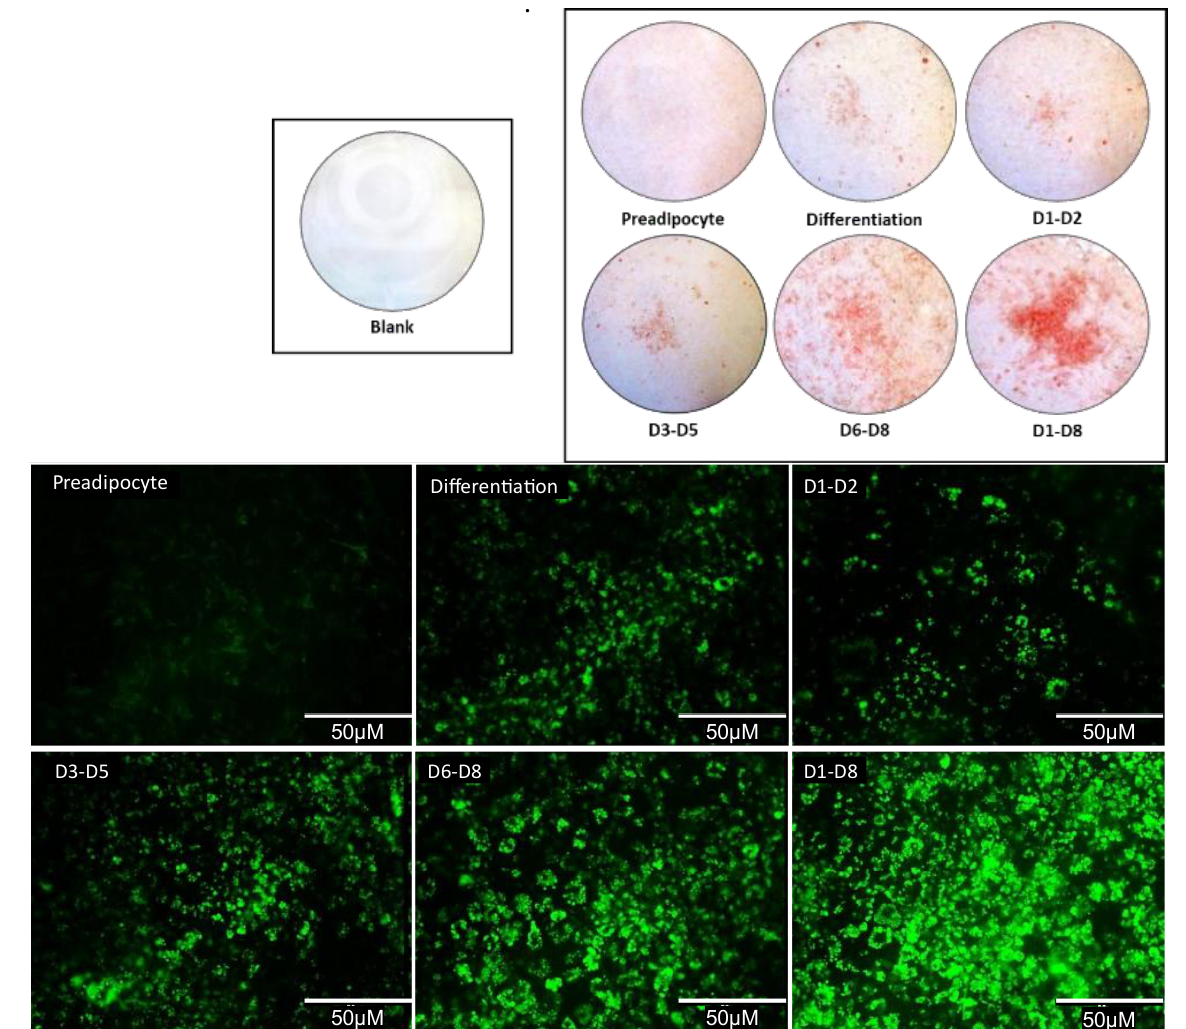
Figure 4. Phenotypic analysis of 2-naphthol’s effect on adipocyte differentiation and lipid accumu- lation by oil red O and BODIPY staining. Upon experimental termination, 3T3-L1 cells were fixed, stained, and photographed either directly (whole-well view) or at × 40 magnification (microscopic view). ( A ) Whole-well imaging comparing ORO (red) stained 3T3-L1 preadipocytes differentiated under chronic 2-NAP treatments versus their controls. ( B ) Confocal microscopic images of BODIPY 493/503 (green) stained neutral lipid content in 3T3-L1 cells under chronic 2-NAP treatment. The scale bar spans 50 μM.